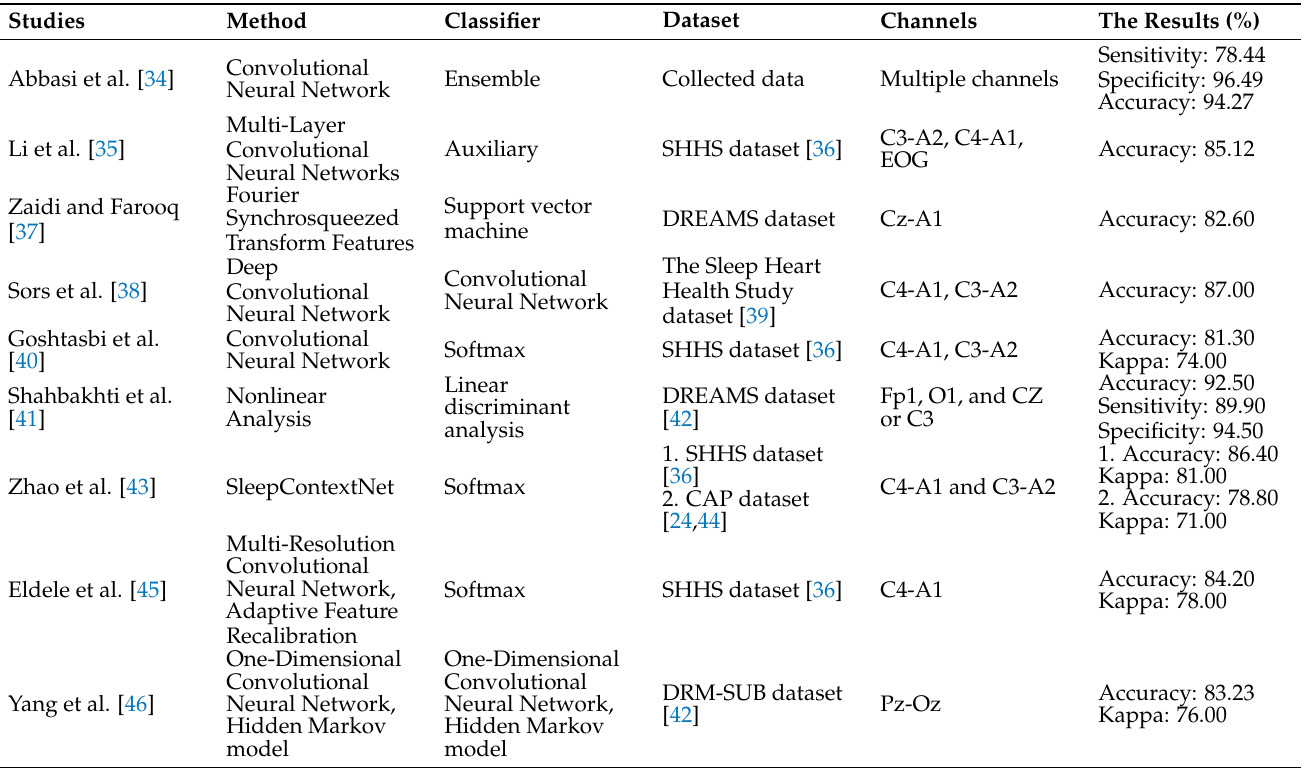
Table 1. Literature review on sleep stage